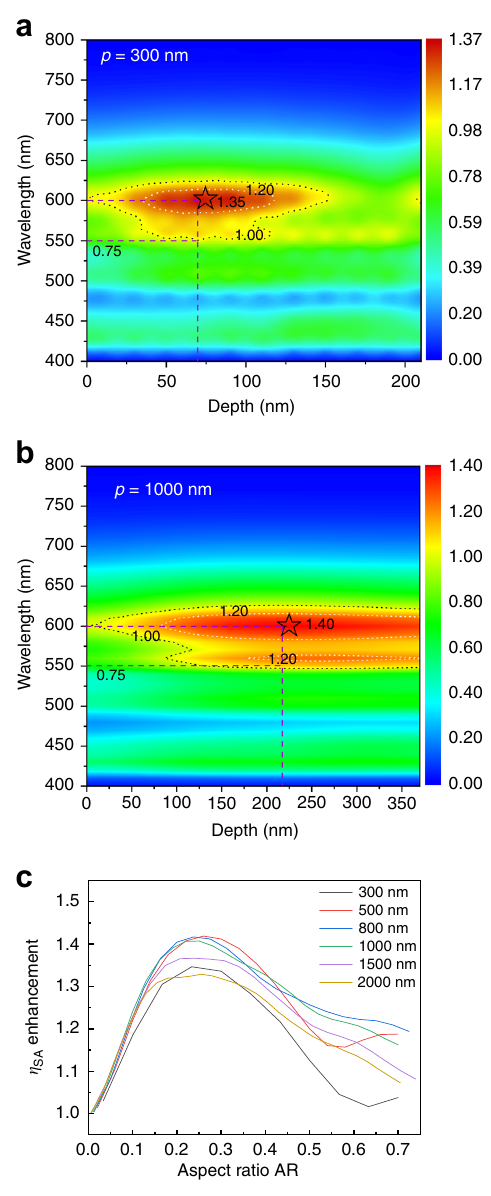
Fig. 5 Numerical simulation of the enhancement for white OLEDs. The depth of 0nm indicates fl at devices. The spectra for fl at devices are normalized as [0, 1]. The simulated intensity for devices on nanostructures at different wavelength is then normalized to the maximum intensity of the fl at device. a White OLEDs on nanostructures with periodicity p = 300nm. b p = 1000nm with different depth are presented. c Numerical simulation results of η SA enhancement factor dependent on the aspect ratio of sinusoidal nanostructures with different